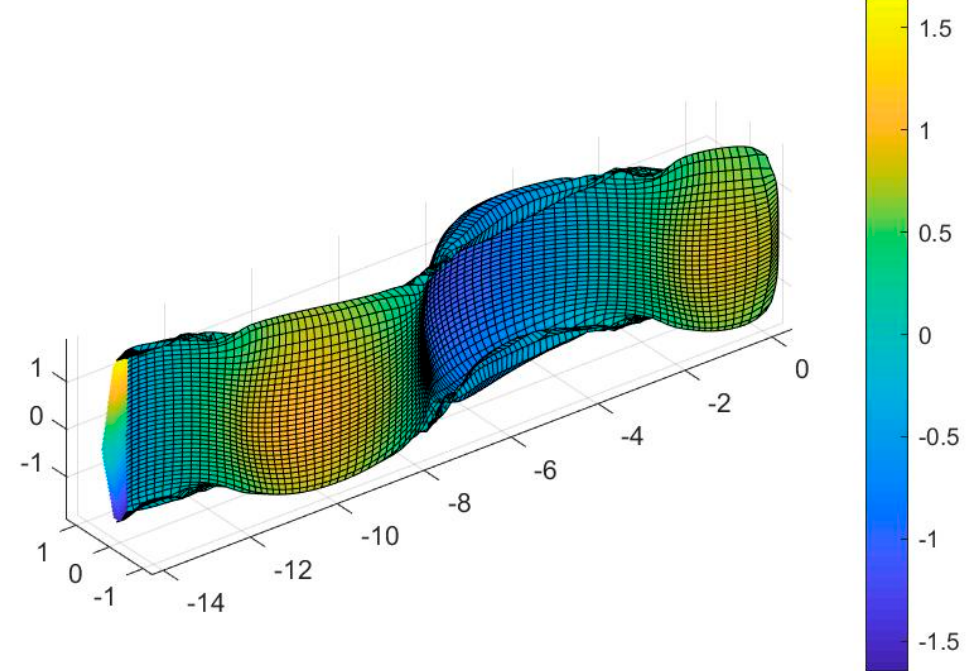
Figure 9. Three-dimensional plot of vortex wake of oscillating heaving-pitching swept back wing of AR = 5, for U = 0.5 m/s, reduced frequency k = 0.1, pitching amplitude θ 0 = 50 ◦ and heaving amplitude h / c = 0.41. Note that for clarity a scale = 10 has been used in the plot for both horizontal and vertical axes.